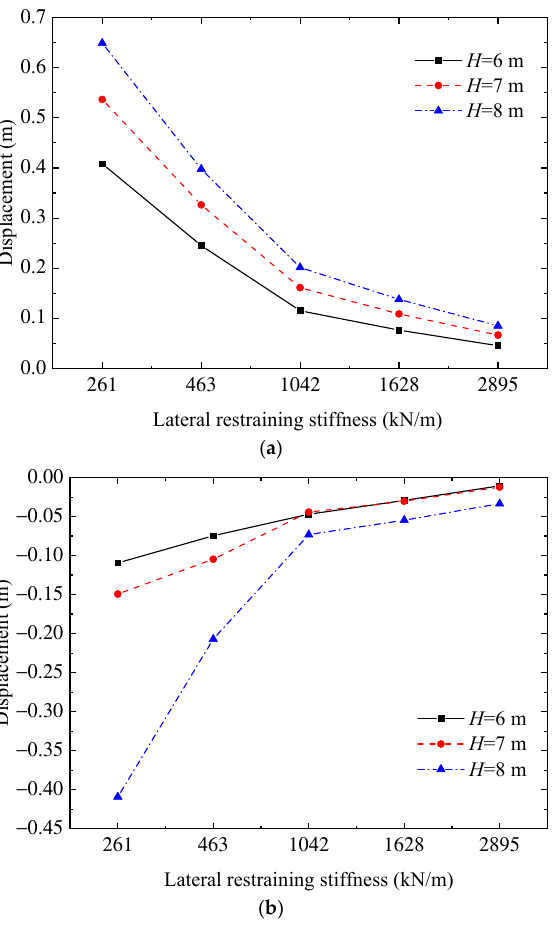
Figure 20. Influence of the lateral restraining stiffnesses on the peak displacement for Case E23/Cs (1). ( a ) Positive displacement; ( b ) Negative displacement. (1). ( a ) Positive displacement; ( b ) Negative